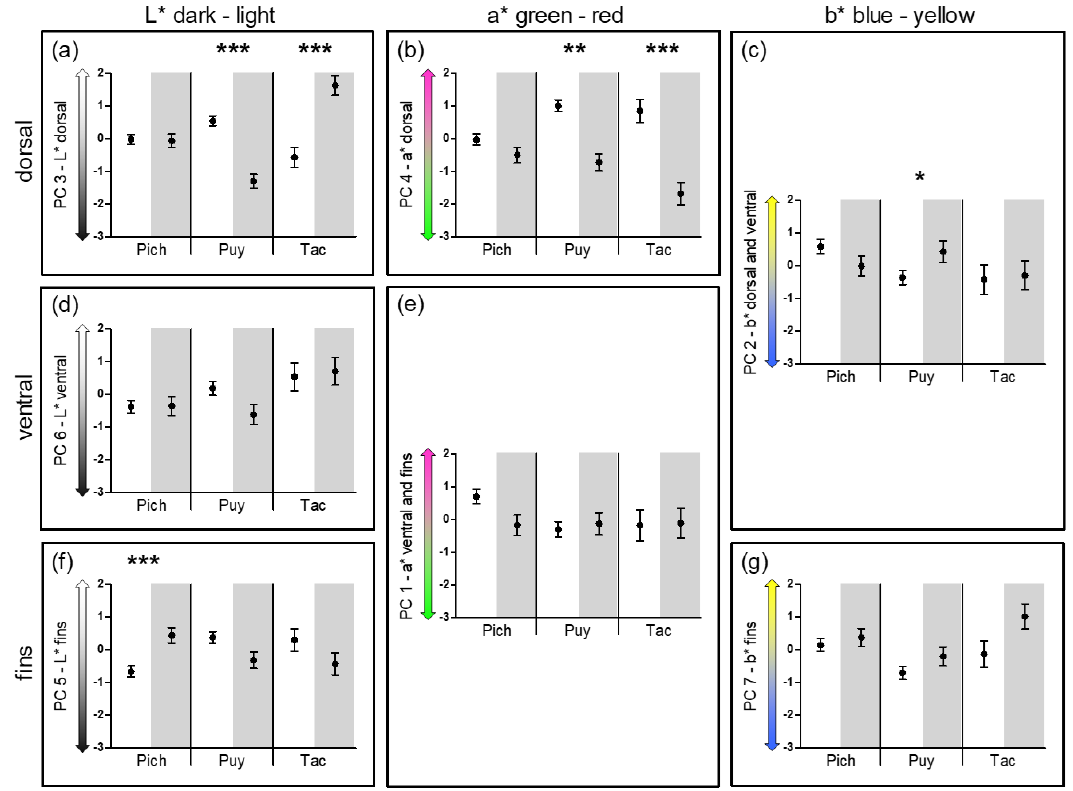
Figure 4. Illustration of the significant effects of drainage × presence of H 2 S detected in post hoc ANCOVAs using principle component (PC) scores as the dependent variables (see Appendix A; Table A3). Shown are residual PC scores ± SE obtained from a preparatory MANCOVA. The results are grouped by body region (dorsal area ( a – c ), ventral area ( d , e ), and fins ( f , g )) and the color ( L *, a *, and b *) captured by the respective PC. In each drainage, white background signifies fish from non-sulfidic habitats, while gray background indicates H 2 S-adapted fish. The asterisks indicate significant results of post hoc independent sample t -tests after Bonferroni correction of the α levels (* p < 0.017, ** p < 0.003, *** p < 0.0003).